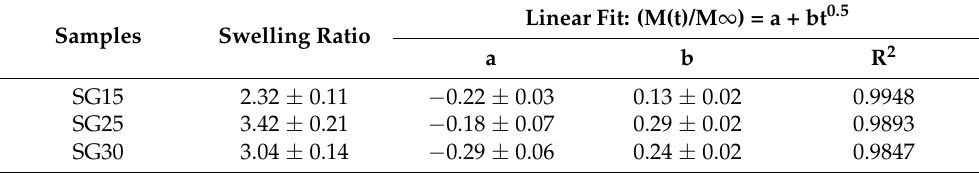
Table 4. Swelling ratio and parameters from the linear fitting performed for up to 80% of the absorption process, according to Fick ´ s diffusion model, for PBS uptake through SG15, SG25, and SG30